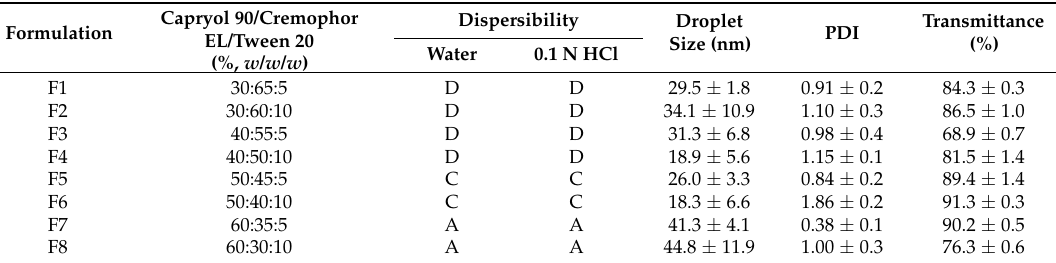
Table 1. Composition of resveratrol self-nanoemulsifying drug delivery system formulations and the results of dispersibility test, droplet size, polydispersity index (PDI) and percentage transmittance.